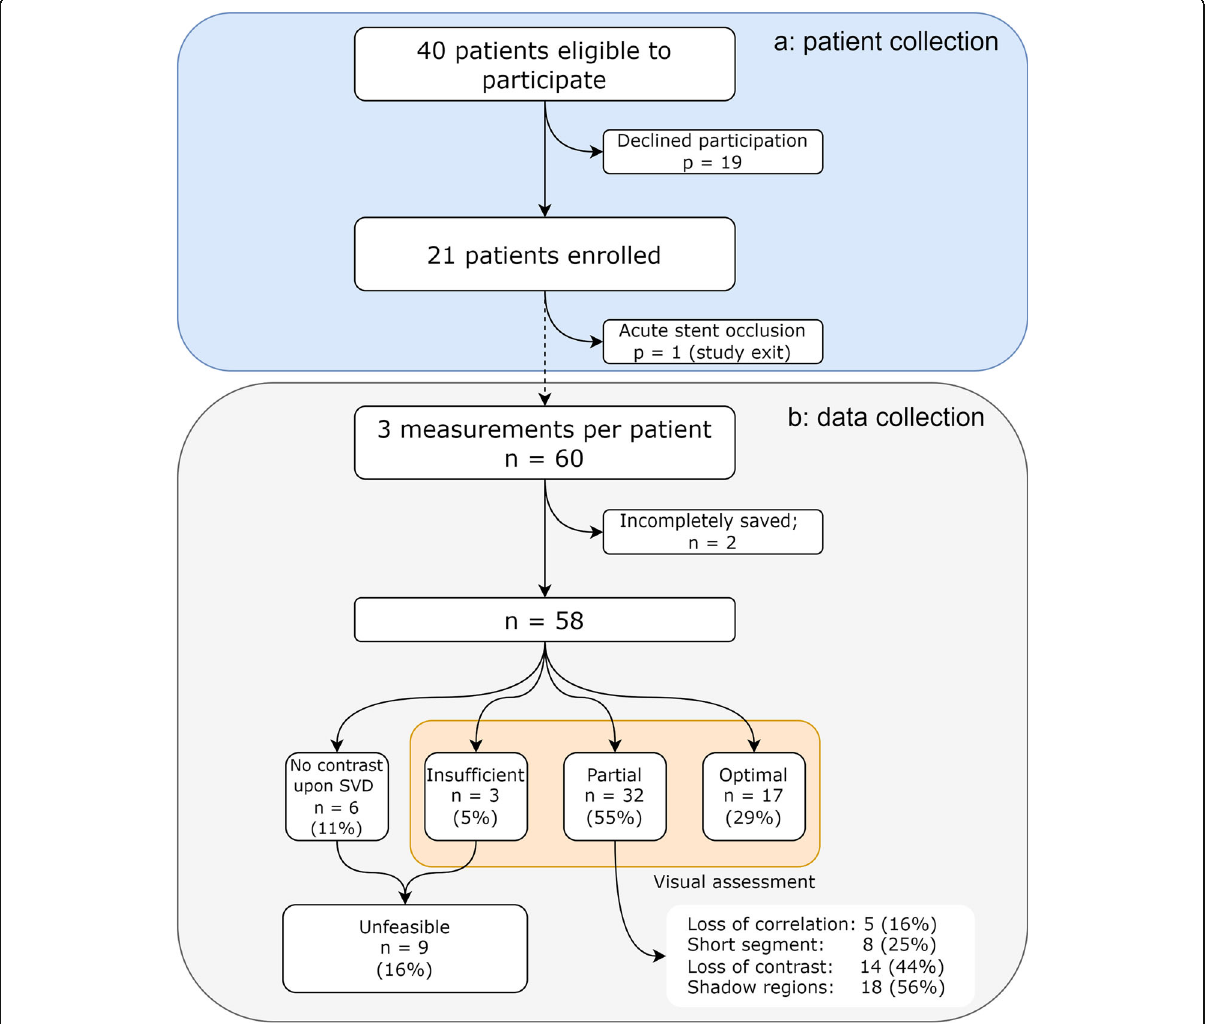
Fig. 1 Enrolment ( a ) and data ( b ) flowchart of complete dataset considering the best measurement per location. n Number of measurements, p Number of patients, SVD Singular value